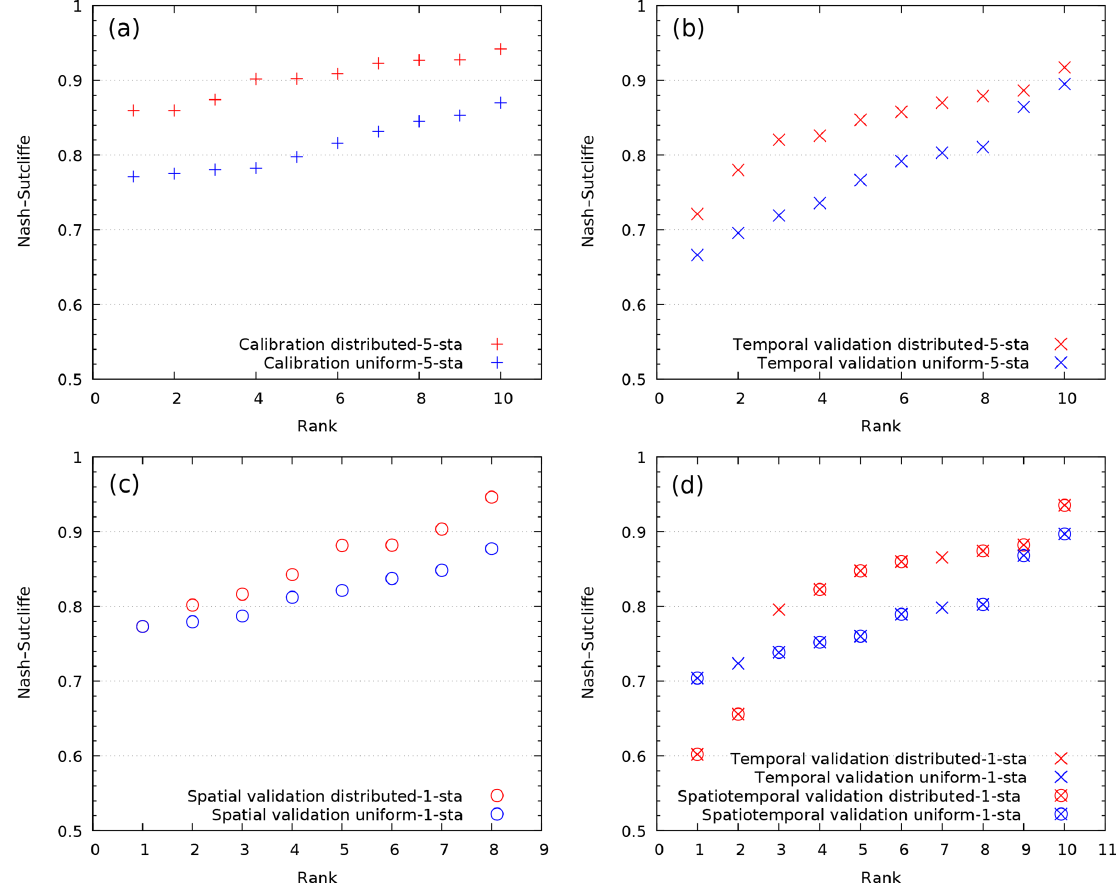
Figure 3. “Statistical” distribution of the NSE criterion comparing distributed vs. uniform calibration and the corresponding validation results: calibration of experiment 1 (a) , temporal validation of experiment 1 (b) , spatial validation of experiment 2 (c) and spatiotemporal validation of experiment 2 (d)